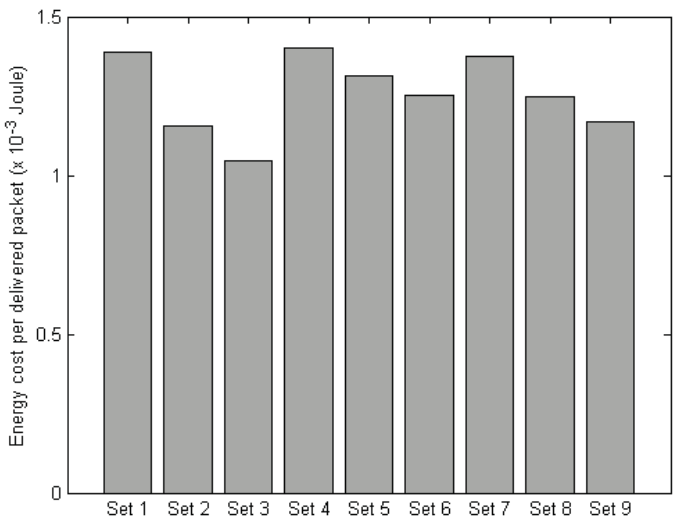
Figure 17. Energy cost of the protocol sets.